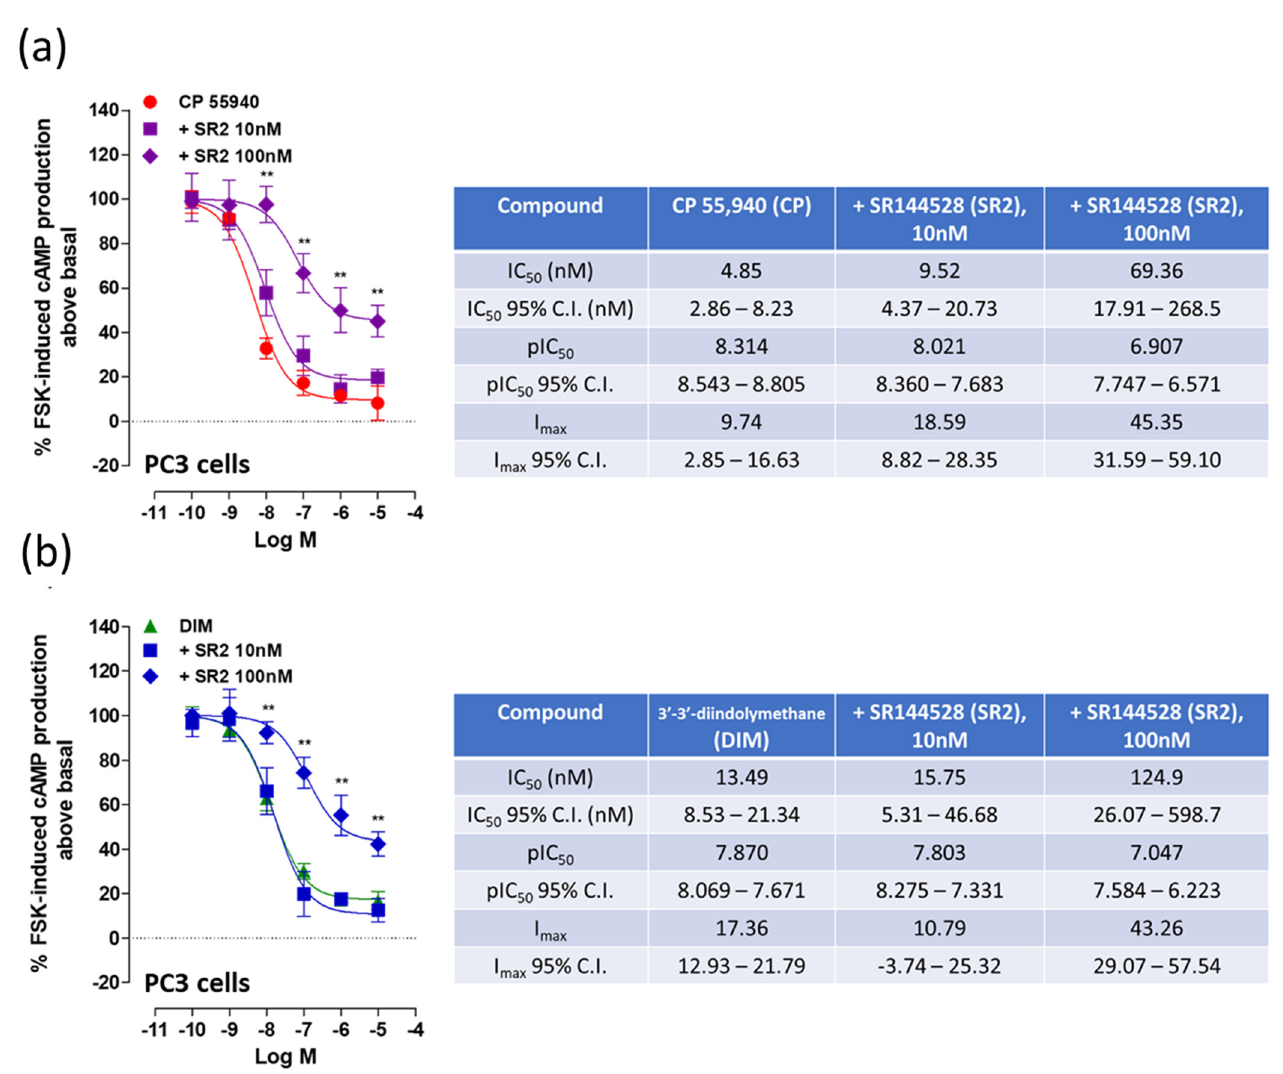
Figure 4. Effects of CP 55,940 ( a ) and DIM ( b ) on FSK-induced cAMP production in PC3 cells. The effects of different concentrations of the CB 2 receptor antagonist SR2 in presence of CP 55,940 ( a ) or DIM ( b ) are also shown. Each data point is the mean percentage value ± S.E.M. ( n = 10). IC 50 , pIC 50 and I max values and 95% confidence intervals are shown in the tables. ** p < 0.01 (paired Student’s t - test).